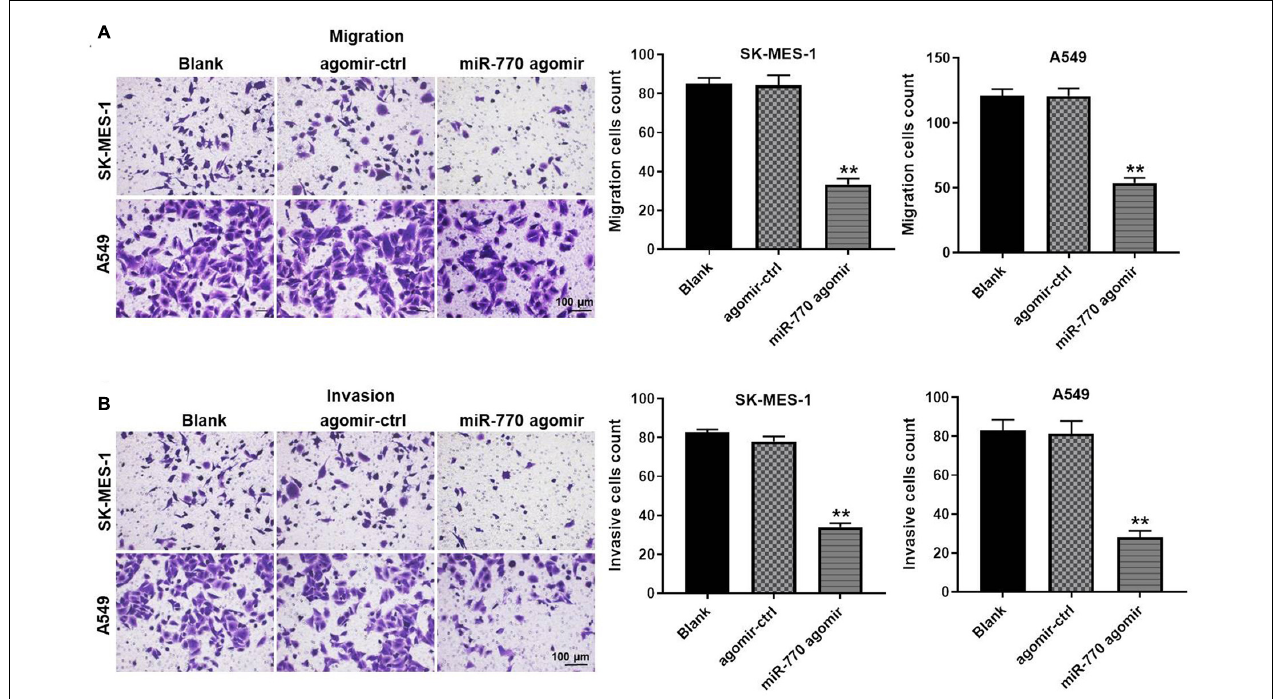
FIGURE 3 | MiR-770 agomir inhibited the migration and invasion of NSCLC cells. (A) The migration of NSCLC cells was investigated by transwell assay. (B) The invasion of NSCLC cells was investigated by transwell assay. N = 3; ∗∗ P < 0.05 compared to